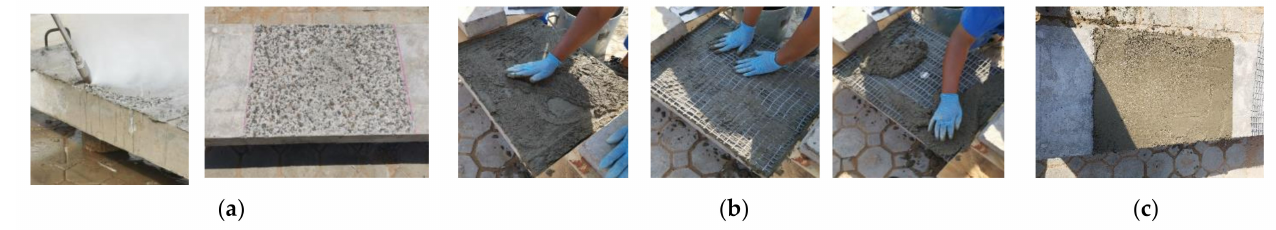
Figure 3. C-FRM strengthening process: ( a ) Surface preparation; ( b ) C-FRM application; ( c ) Strengthened surface.